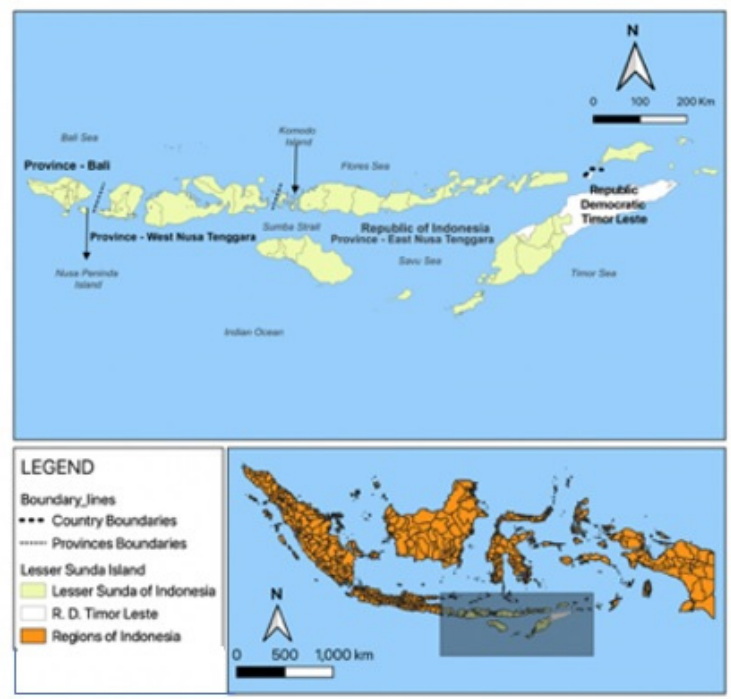
Fig. 1: Geographical location of study area in the Lesser Sunda Islands, Indonesia